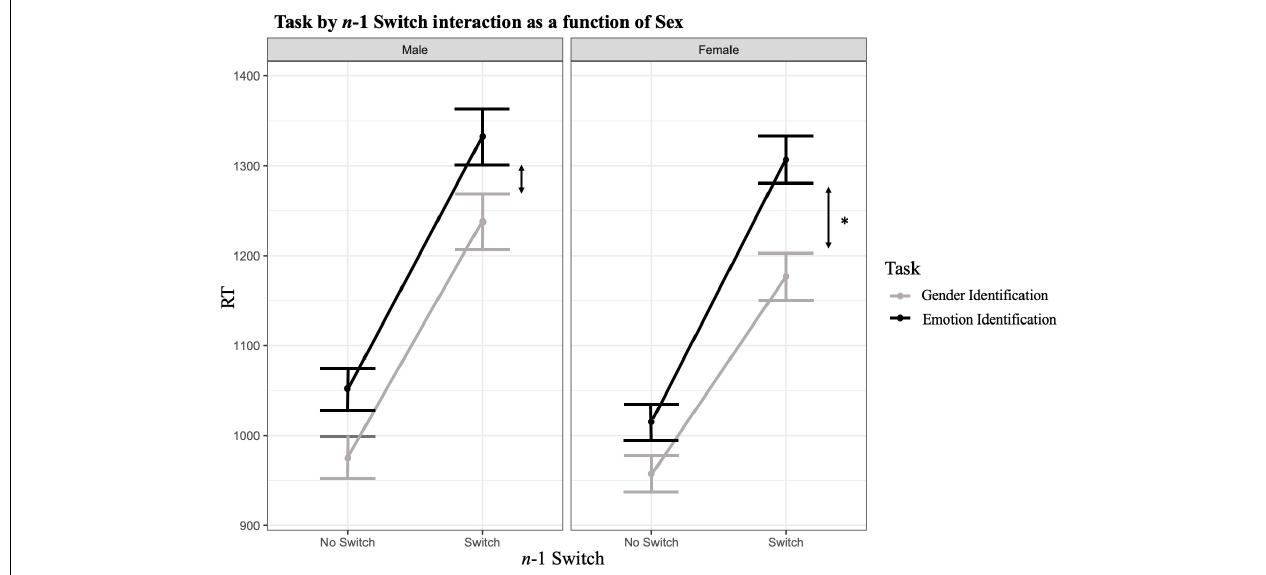
FIGURE 2 | Task by n -1 Switch Interaction as a function of sex. Graphical representation of the n -1 Switch × Task Emotion × Sex interaction. The difference in RT when there is an n -1 Switch × Emotion Task interaction is more pronounced in females versus males. * p < 0.05, ** p < 0.01, *** p < 0.001.